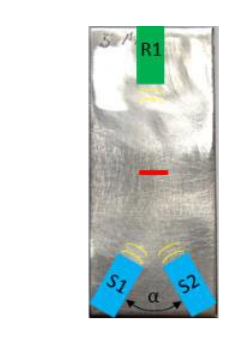
Figure 13. Measuring principle—sample with central defect.